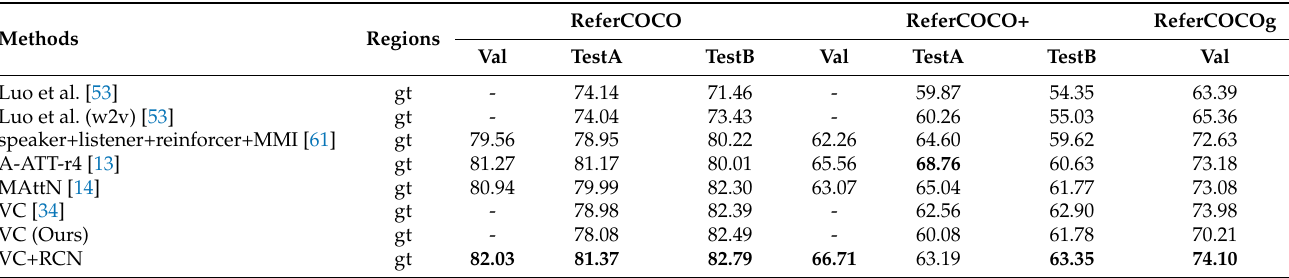
Table 2. VG Comparisons of ReferCOCO, ReferCOCO+, and ReferCOCOg (accuracy in %). VC (ours) means the results of the author’s codes in our environment are retrained. The bold type indicates the state-ot-the-art performance.